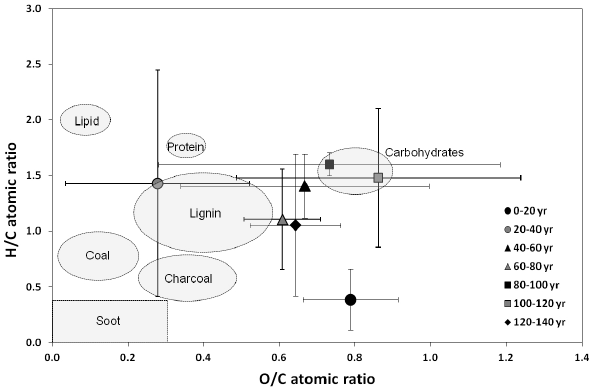
Fig. 3. Relative proportion of BC in total organic carbon as a func- tion of time for all samples. Sample AS6 was classified as an outlier and removed from the regression.